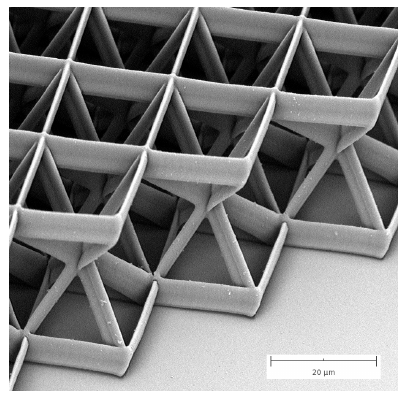
Figure 5. Example of imaging of a TPP microstructure complex geometries by SEM. Scale bar is 20 µm.